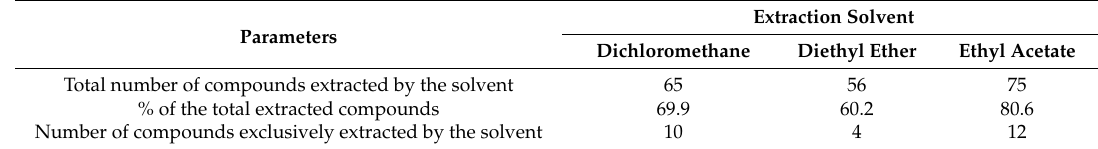
Table 5. Efficiency of solvents in the extraction of organic compounds from GG100